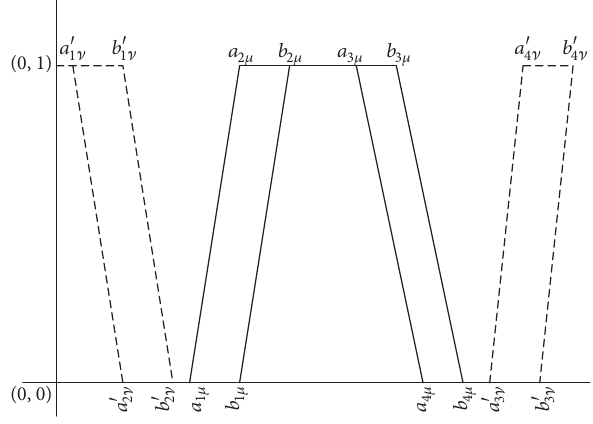
Figure 5: Pictorial representation of Example